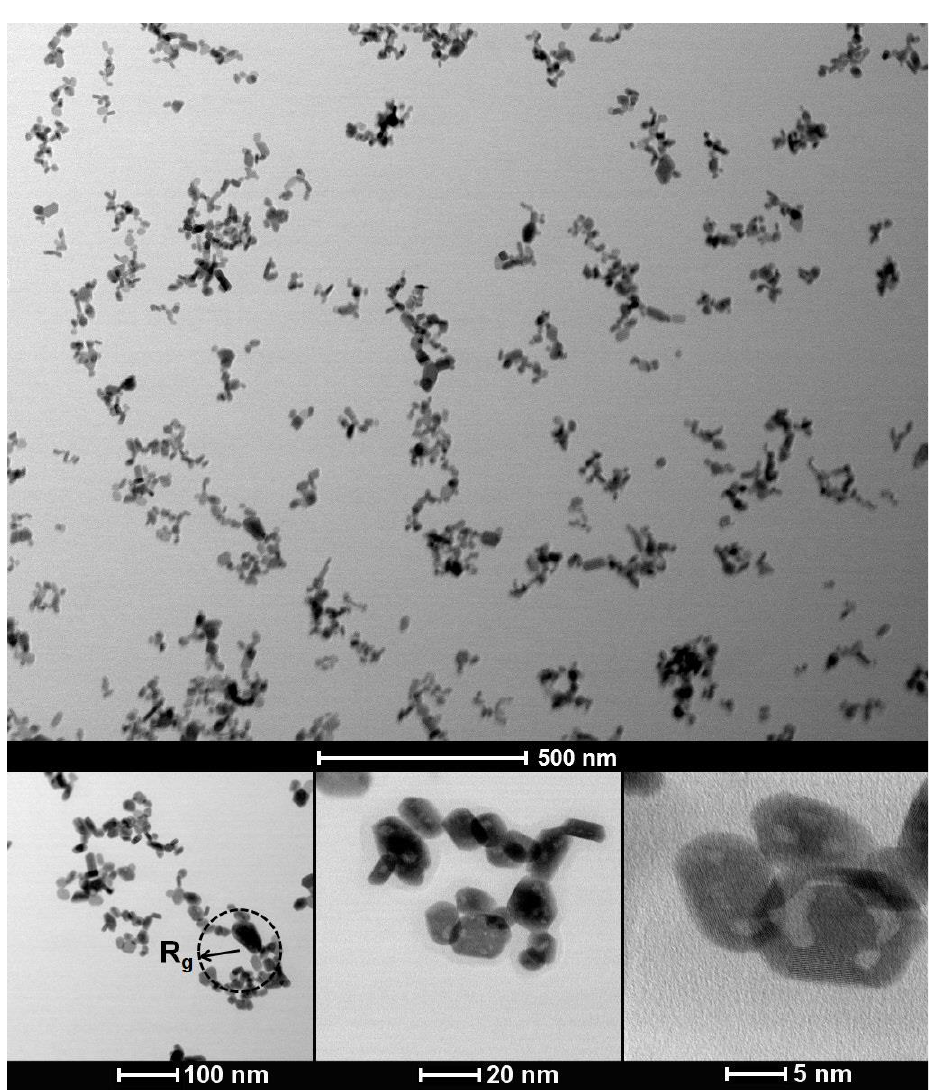
Figure 3. TEM images of 0.1 at. % Nd 3+ : LaF 3 nanoparticles and clusters formed by them placed on a TEM copper grid with carbon film and dried for several hours. At the bottom left of the figure, an example of the calculated gyration radius for 2D image is drawn in black.